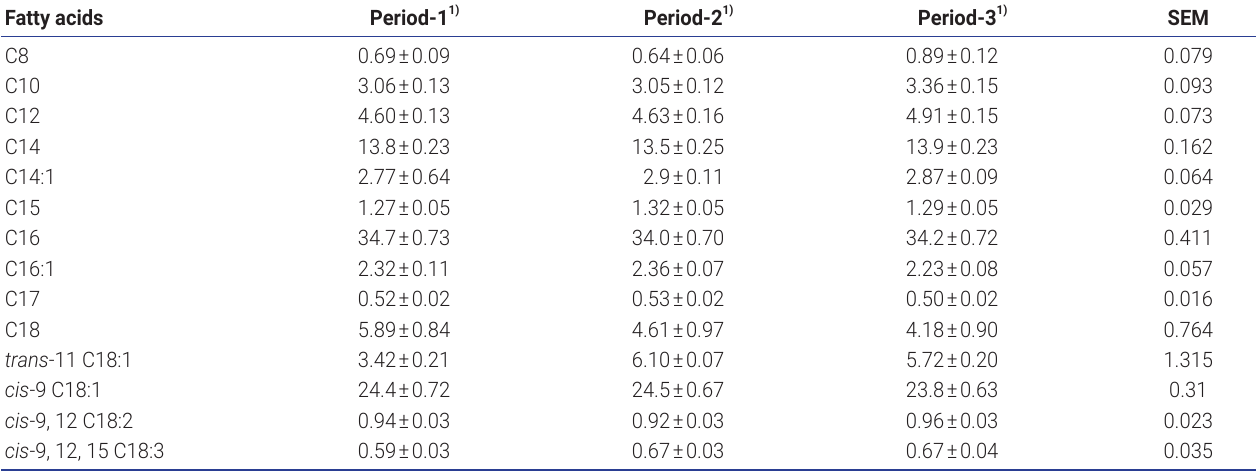
Table 3. Effects of feeding periods on fatty acid composition (% of total fatty acid) in milk of dairy cows Fatty acids